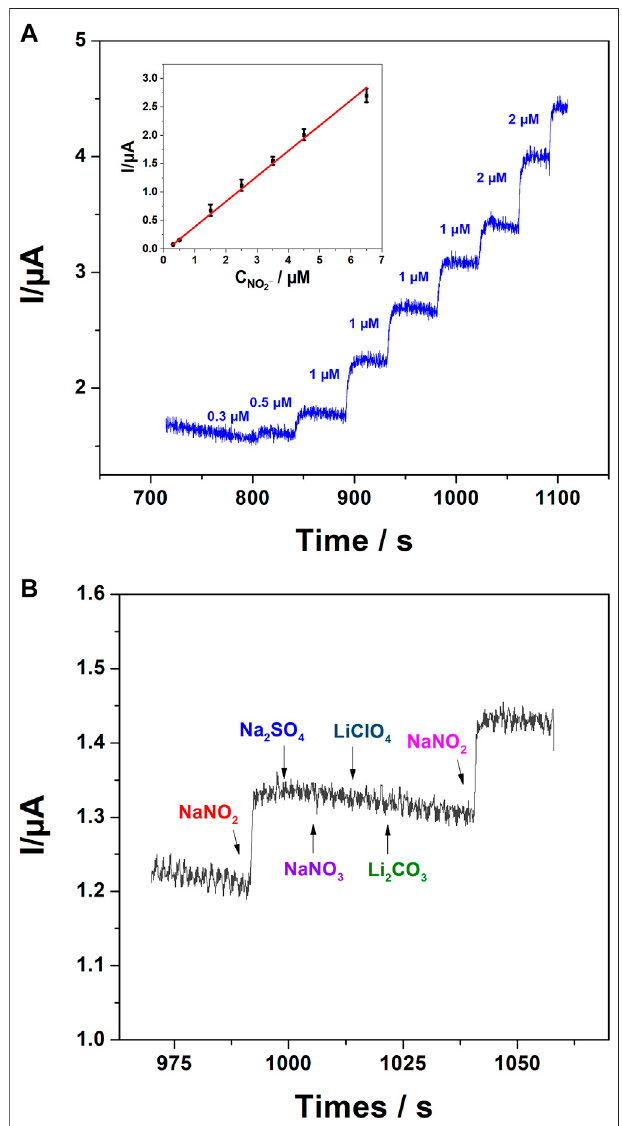
FIGURE 9 | (A) Amperometry of poly 1,8-DAN/f-MWCNT/CPE in 0.1 M PBScontaining0.1 M KClatpH 7.2witha fi xedpotential of0.9 Vvs. Ag/AgCl at consecutive additions of nitrite, insert the calibration plot of the current versus nitrite concentrations. (B) Effect of some interference components on nitrite